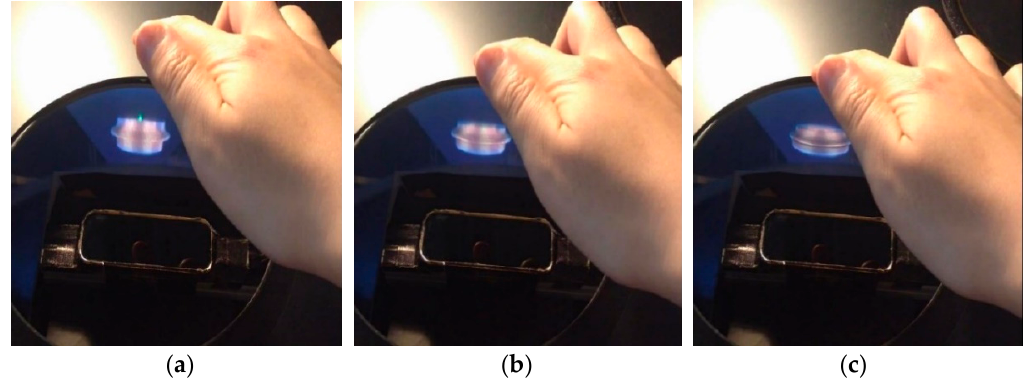
Figure 12. Reducing the total height: ( a ) → ( b ) → ( c ).